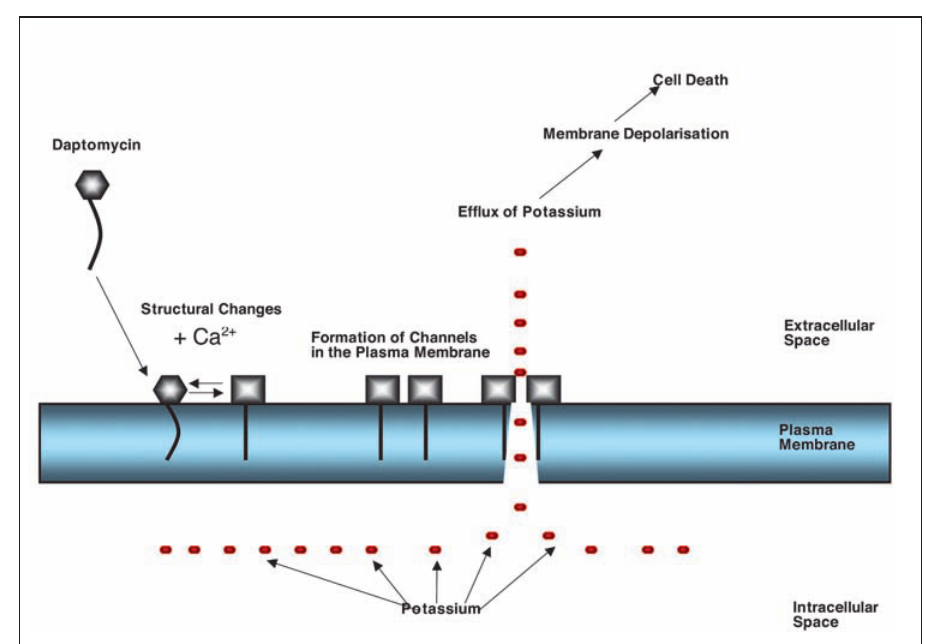
Figure 2 Scheme of the mechanism of action of